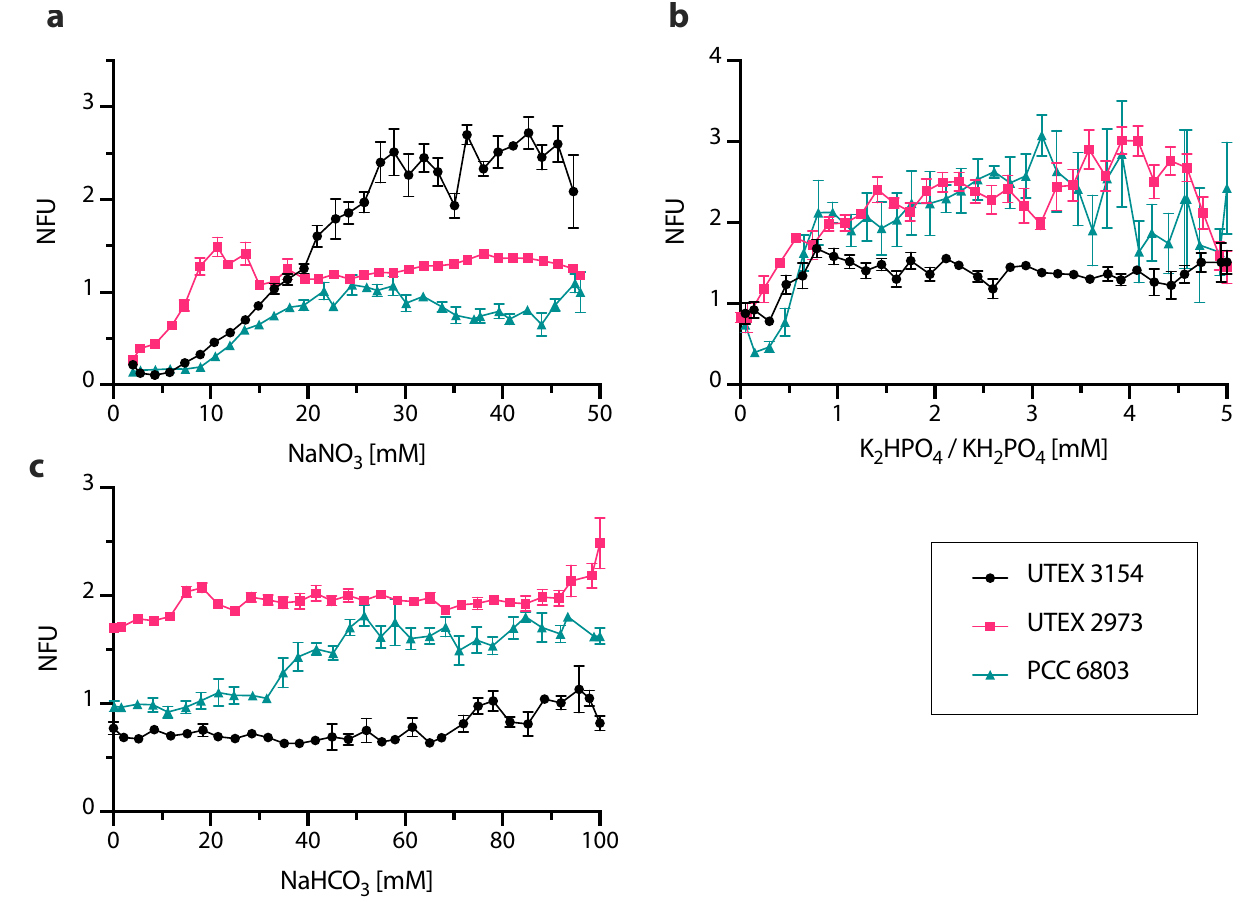
Figure 4. Highly resolved dose–response screenings of key macronutrients in UTEX 3154, UTEX 2973 and PCC 6803. (a) Normalized autofluorescence after 7 days in response to varying concentrations of NaNO 3 . (b) Normalized autofluorescence after 7 days in response to varying concentrations of K 2 HPO 4 (UTEX 2973, PCC 6803) or KH 2 PO 4 (UTEX 3154). (c) Normalized autofluorescence after 7 days in response to varying concentrations of bicarbonate (NaHCO 3 ). Data points are averages of 10 ± 3 droplets. Error bars represent standard deviation. Normalized autofluorescence is shown as